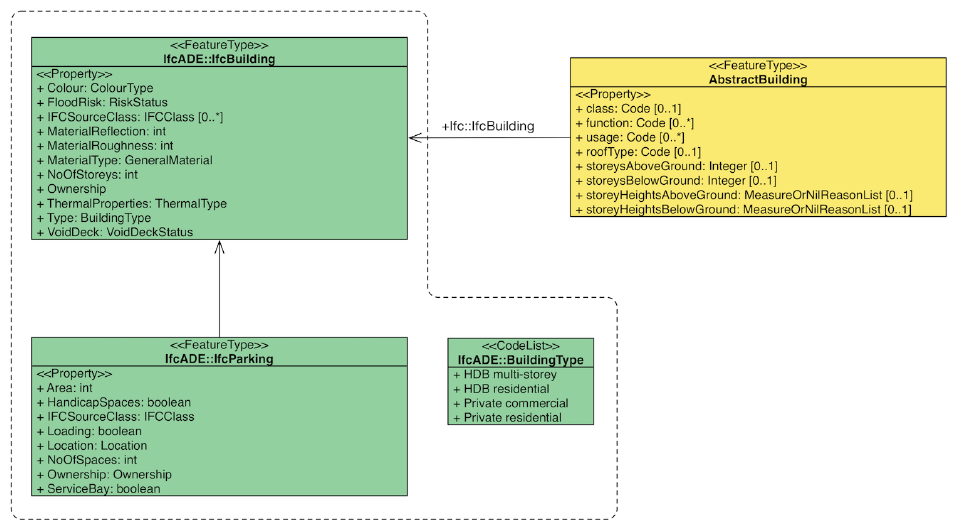
Figure 8. Excerpt from a simple ADE extending the CityGML data model and supporting the conservation of potentially useful information from architectural models and other